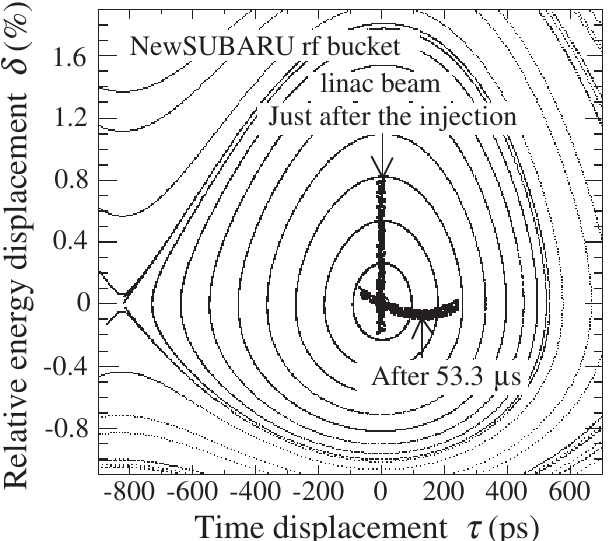
FIG. 4. Result of a particle tracking simulation for the (cid:2) 130 kV ). A uniform rectangular NewSUBARU rf bucket ( V rf distribution, with a 20 ps bunch length and 1.0% energy spread, are used for the linac beam. The center energy is (cid:8) 0 : 3% . The thick lines represent the beam occupancy at injection ( t (cid:2) 0 ) and (cid:2) 53 : 3 (cid:5) s ). measurement ( t (cid:2) T MEAS